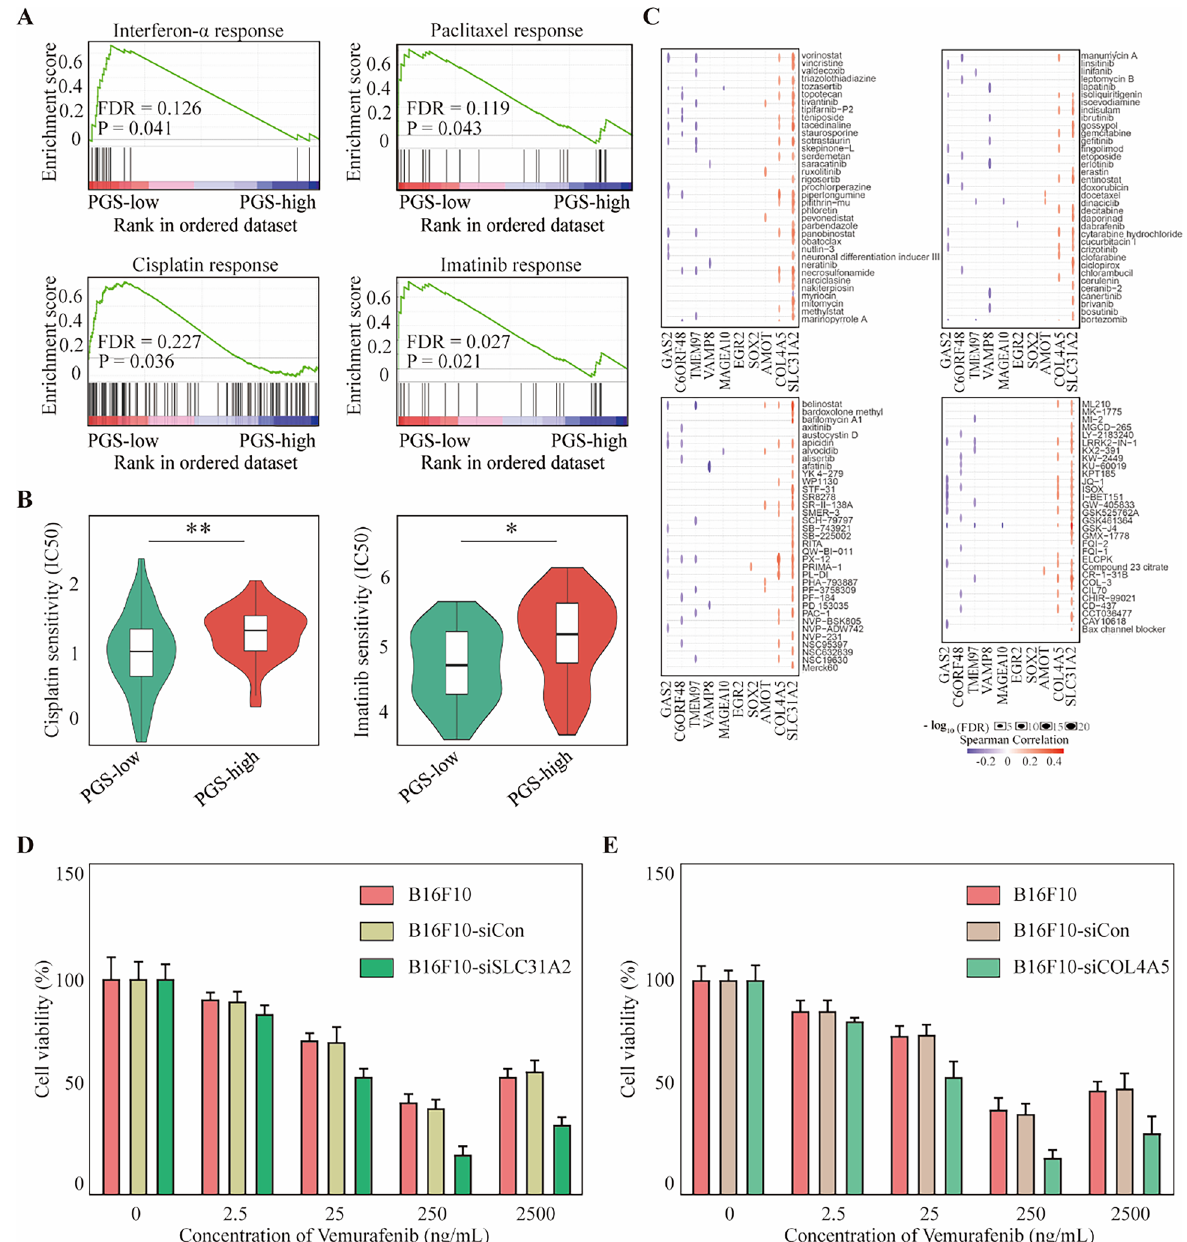
Figure 6. Correlation between the PGS score and chemotherapeutic drug response in melanoma. ( A ) GSEA assessment of interferon-α, paclitaxel, cisplatin and imatinib response pathways in the PGS-low and -high groups. ( B ) Sensitivity analysis of cisplatin and imatinib between the PGS-low and -high groups. ( C ) Spearman correlation analysis between the 10 pyroptosis genes and 135 chemotherapeutic drugs. ( D , E ) Cell viability of B16F10 melanoma cells transfected with siCon, siSLC31A2, and siCOL4A5 and naive cells treated with different concentrations of vemurafenib. Statistical analysis: * p < 0.05, ** p < 0.01. This figure was created using GSEA software 4.2.1 (https:// www. gsea- msigdb. org/ gsea/ index.